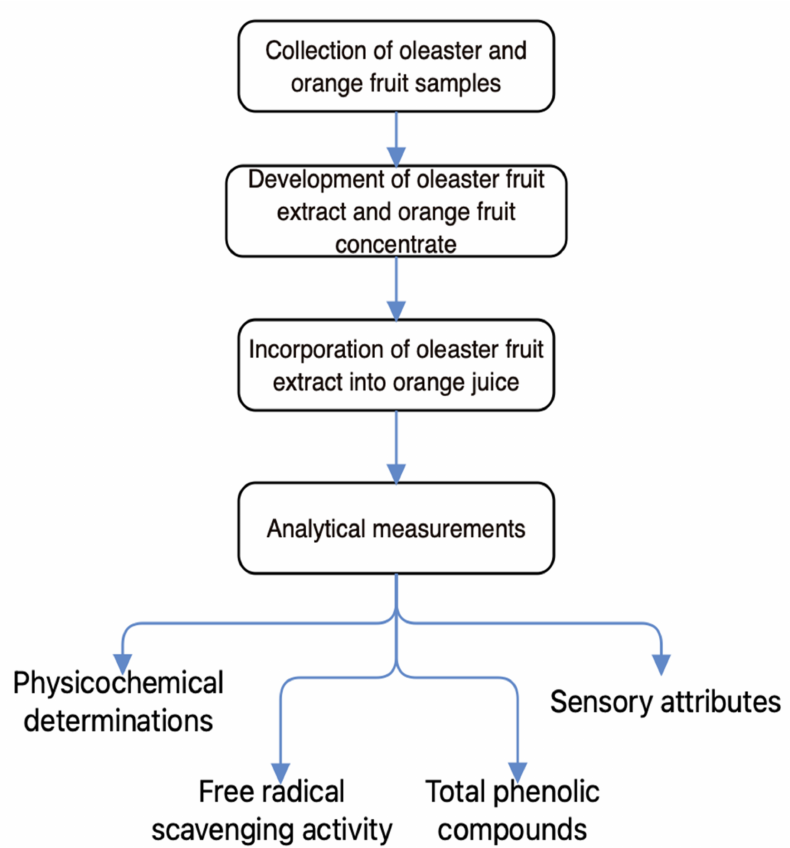
Figure 5. A schematic overview of experimental program, indicating the major stages of this current work, from the collection of oleaster and orange fruit samples, the development of oleaster fruit extract and orange fruit concentrate, the incorporation of oleaster fruit extract into orange juice, to the analytical